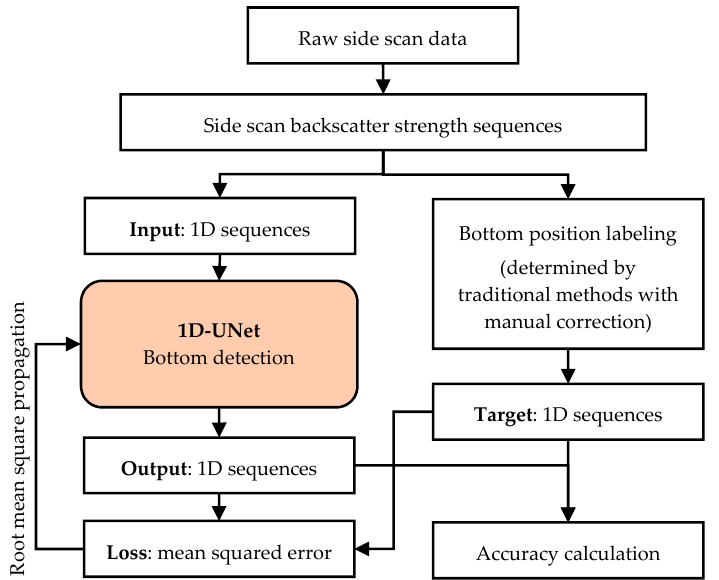
Figure 2. The flow chart of the proposed one-dimensional (1D)-UNet model.